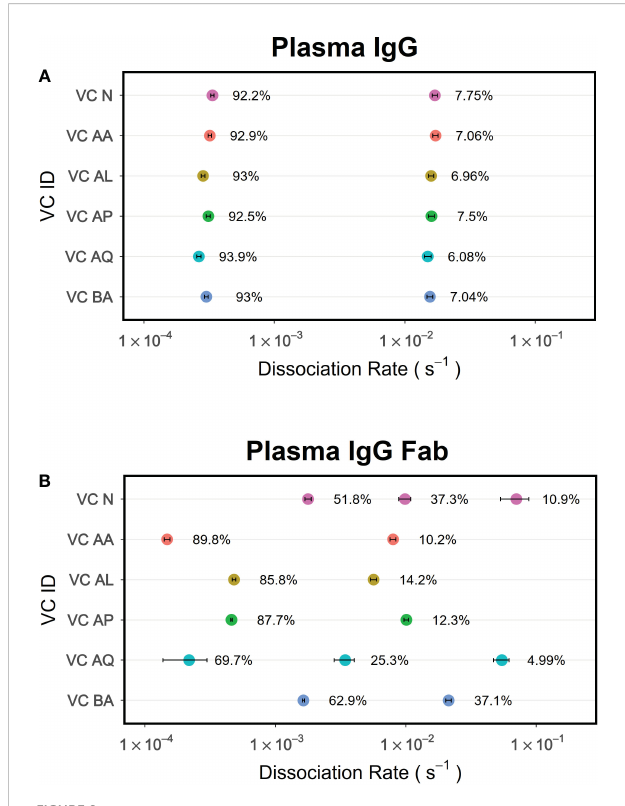
FIGURE 9 PAART analysis of polyclonal antibody Fab dissociation rather than the polyclonal IgG antibodies provides enhanced resolution of antibody heterogeneity. Data of polyclonal IgG antibodies (A) and the corresponding Fab (B) from the HIV-1 virus controllers interacting with BG505gp140 T332N SOSIP.664 antigen were analyzed using PAART to derive the minimal number of k d values needed to explain the dissociation phase. The error bars associated with symbols indicate the standard error in the estimate of k d